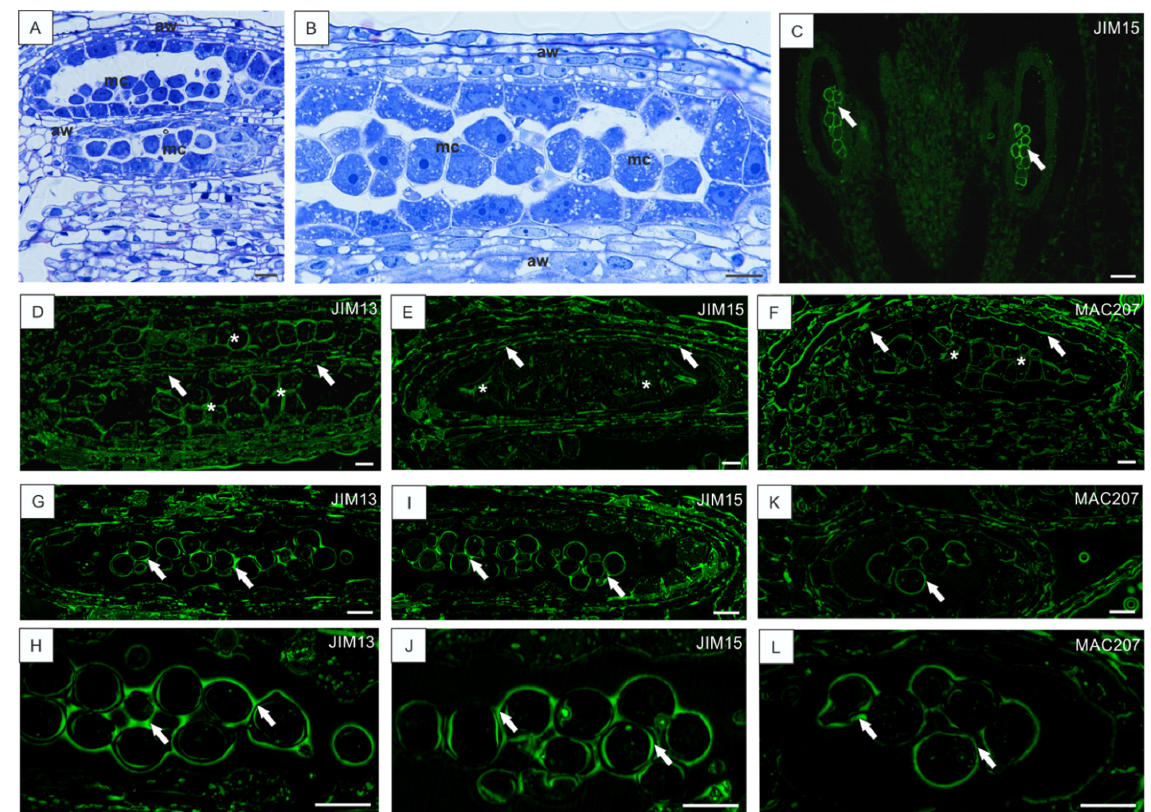
Figure 4. AGP localization in B. perennis anthers at early stages developing at low temperature. Histology of anther tissues during microsporocyte differentiation ( A , B ). Section of the whole anther with visible AGPs labeled in microsporocytes (arrows); reaction with JIM15 ( C ). AGPs in undifferentiated cell walls of the anther parietal layer (arrows) and microsporocytes in the anther loculus (asterisks); reaction with JIM13 ( D ), JIM15 ( E ), and MAC207 ( F ). AGPs in walls around microsporocytes (arrows) during the first meiotic division and in somatic cell walls; reaction with JIM13 ( G , H ), JIM15 ( I , J ), and MAC207 ( K , L ). Toluidine blue staining: ( A , B ). Immunolabeling: ( C – L ). Bars: 10 µ m ( A , B ), 20 µ m ( C ), 10 µ m ( D – L ). Abbreviations: aw—anther walls,